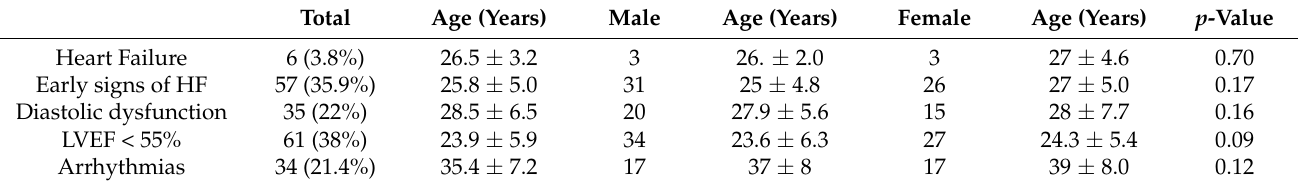
Table 5. Cardiovascular outcomes distribution.